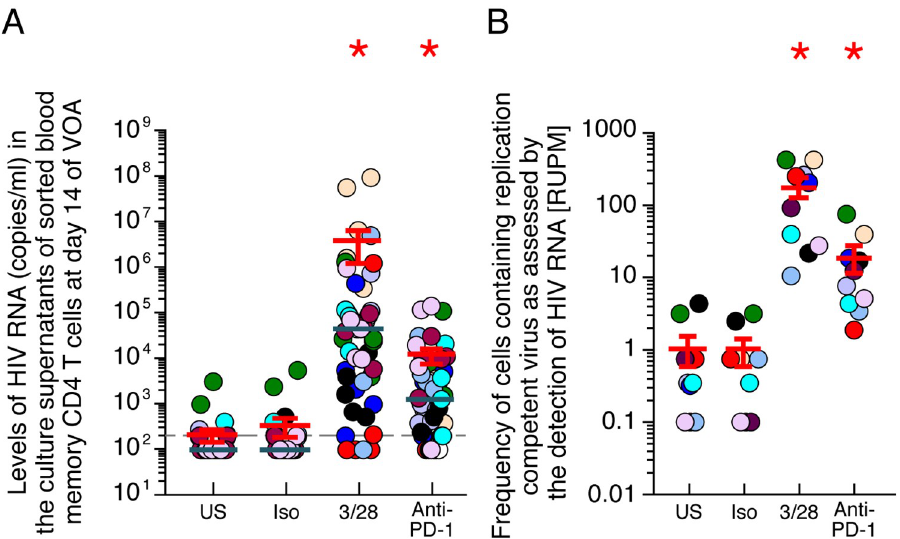
Fig 6. Anti-PD-1 monoclonal antibody Pembrolizumab reactivates HIV-1 replication from latently infected CD4 T cells in vitro . (A) Levels of HIV-1 RNA produced in the culture supernatants at day 14 of VOA of sorted blood resting memory CD4 T cells isolated from treated aviremic HIV-1-infected individuals (N = 10; 5 replicates per condition). Undetectable values were arbitrarily defined as 100 HIV-1 RNA copies/ml. (B) Estimated frequencies of inducible replication competent virus as measured by Replication Competent Unit per million (RUPM) in sorted blood resting memory CD4 T cells. Red bars correspond to mean ± SEM (A-B) . Green bars correspond to median (A) . HIV-infected individuals were color-coded (A-B) . Red stars indicate statistical significance ( P < 0.05) as compared to unstimulated condition (A-B) . Statistical significance ( P values) was obtained using One-way ANOVA (Kruskal- Wallis test) followed by Wilcoxon Matched-pairs two-tailed Signed Rank test (A) or using Extreme Limiting Dilution analysis (ELDA) (http://bioinf.wehi.edu.au/software/elda/) (B) . “US” corresponds to unstimulated, “Iso” corresponds to isotype control, “3/28” corresponds to anti-CD3/anti-CD28 MAbs, “anti-PD-1” corresponds to Pembrolizumab.